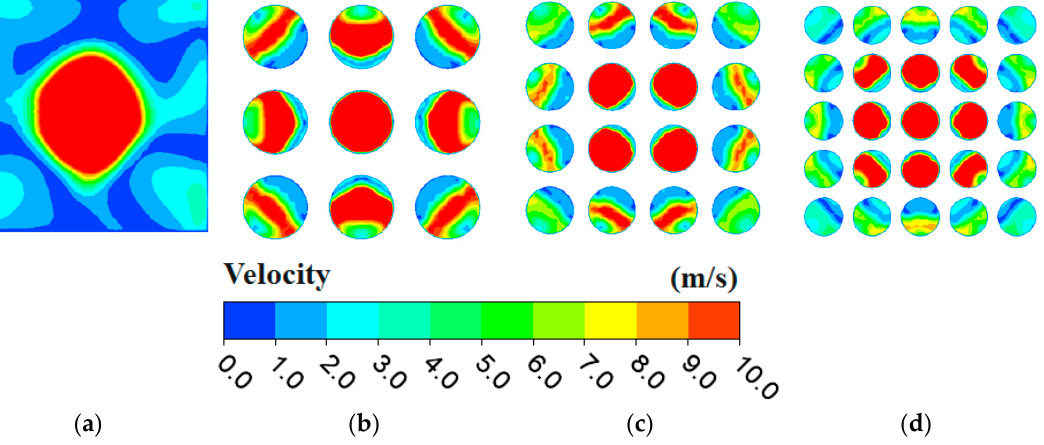
Figure 12. Velocity contours at SPB cross-section ( Δ L = 0) for four cases, ( a ) without SPB, ( b ) 3 × 3 SPB, ( c ) 4 × 4 SPB, and ( d ) 5 × 5 SPB.